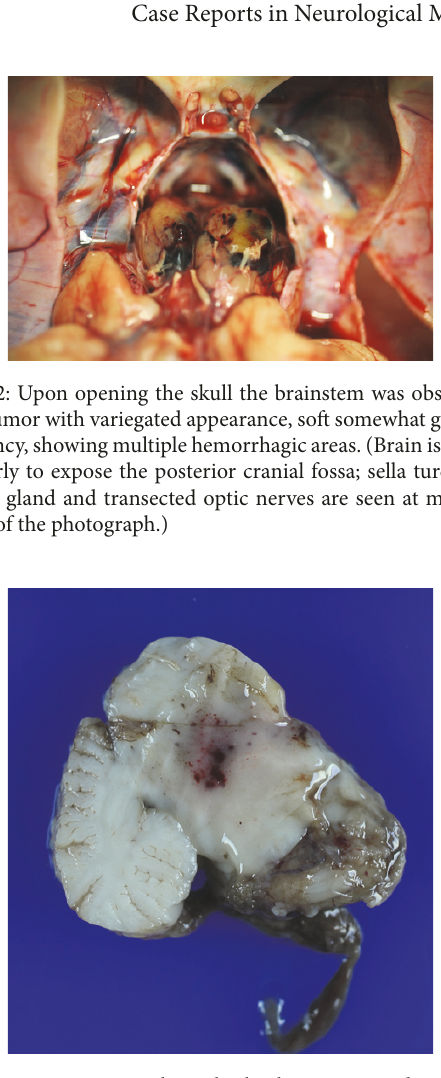
Figure 3: Cut sections through the brainstem and cerebellum showingtheneoplasminfiltratingtheentirepons,extendingintothe midbrain, medulla, cerebellar peduncles, and caudal diencephalon. Specimen after formalin